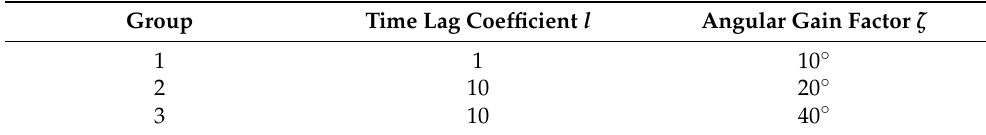
Table 4. Comparison of experimental parameters. Group